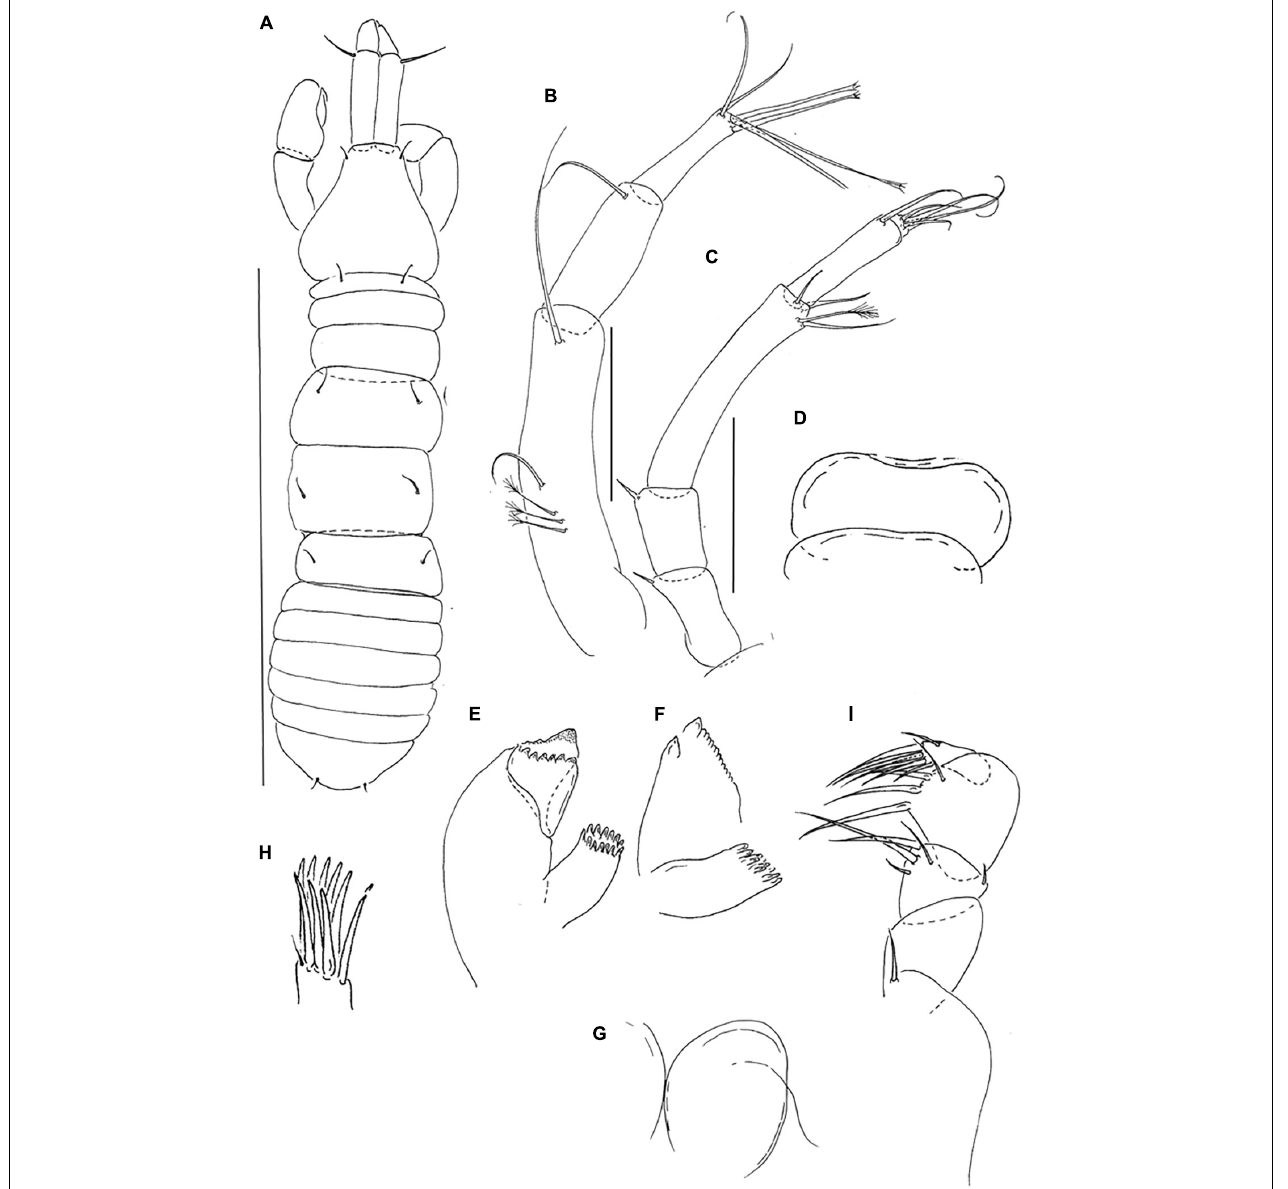
FIGURE 6 | Pseudotanais barossai sp. nov; neuter (J61545), (A) , dorsal; (B) , antennule; (C) , antenna; (D) , labrum; (E) , left mandible; (F) , right mandible; (G) , labium; (H) , maxillule; endite; (I) , maxilliped palp. Scale lines (A) = 1 mm, (B–I) = 0.1 mm.